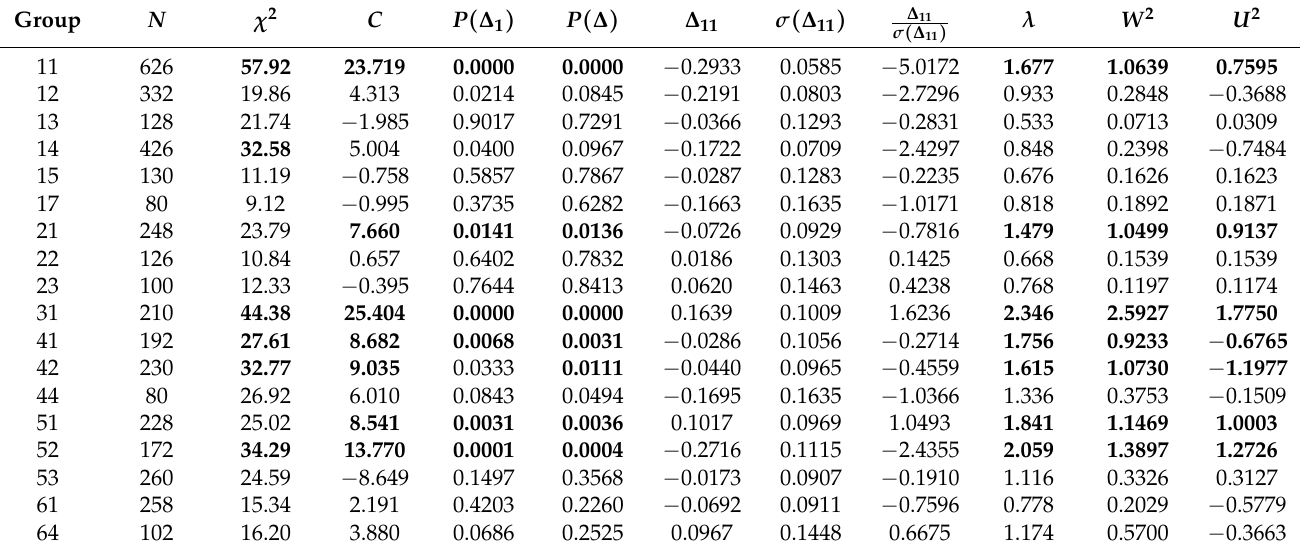
Table 3. Test for isotropy of the orientations of the galaxy plane. The distribution of the angle δ D of galaxies; inclination was calculated on the basis of the value of the parameter q 0 , depending on the morphological types of galaxies.